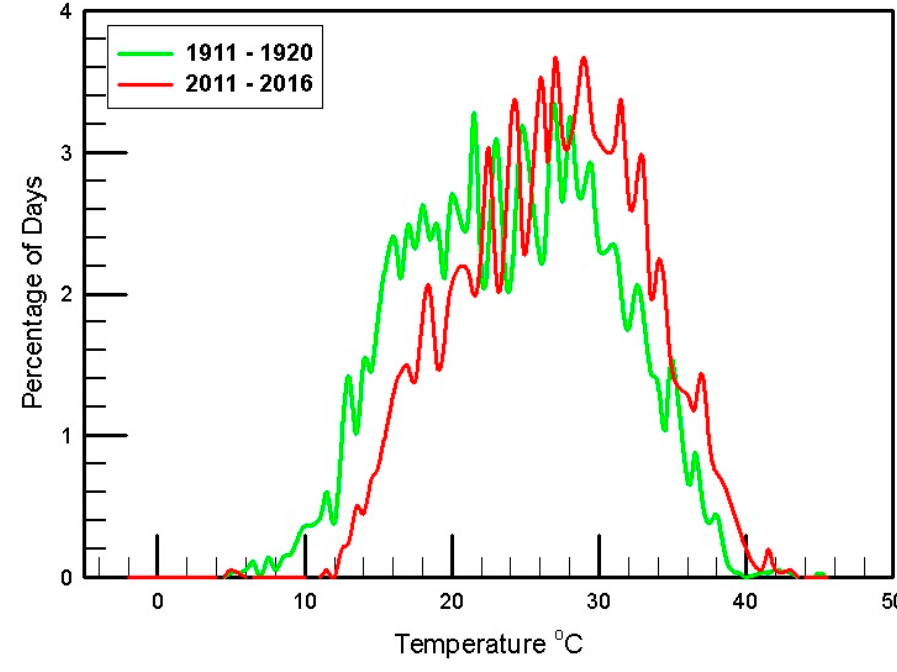
Figure 4. Frequency of daytime temperatures in Pasadena by decade, 1911–2016.